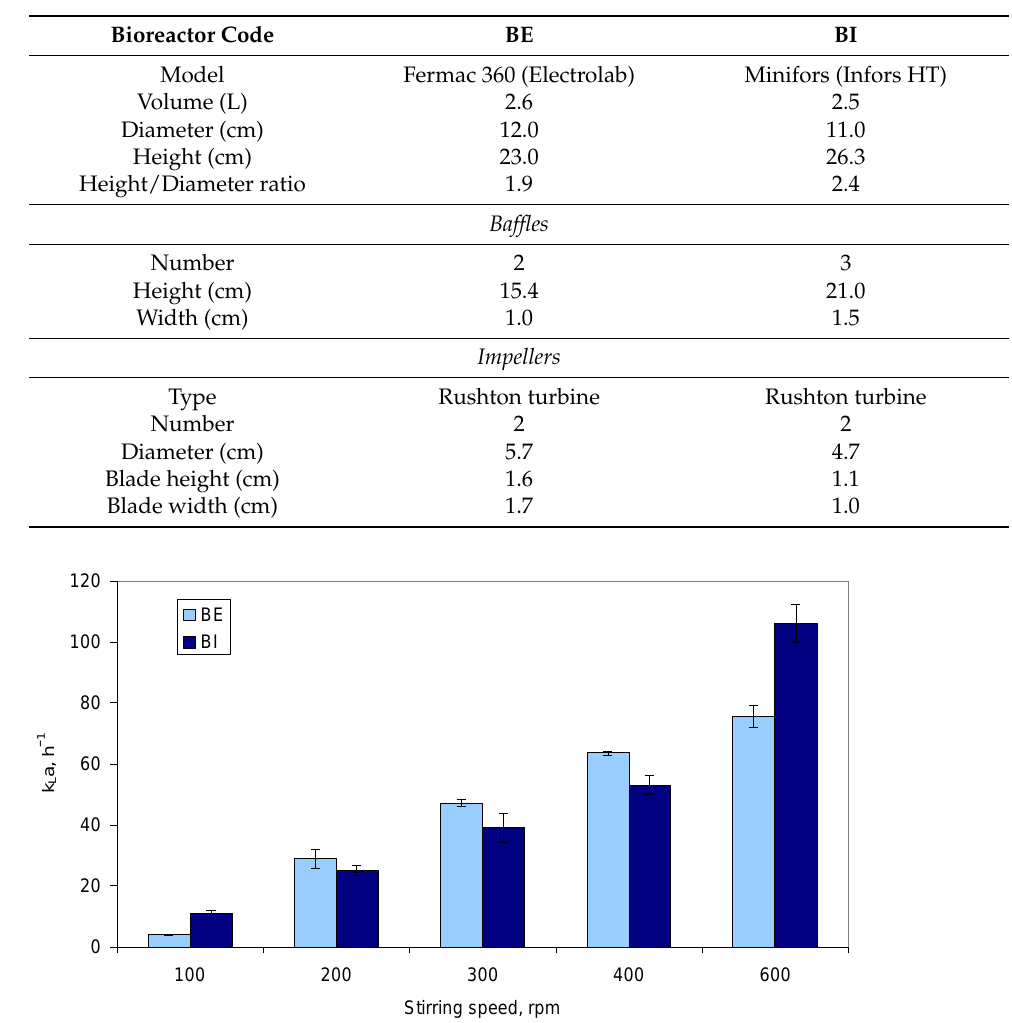
Table 1. Geometric parameters of the bioreactors used in this study.